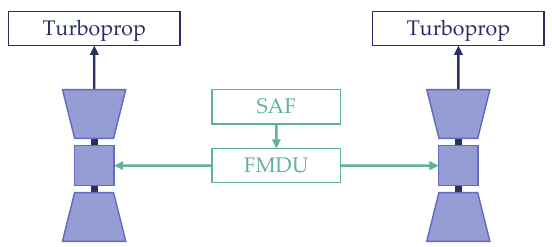
Figure A1. Architecture 0: Conventional reference architecture.